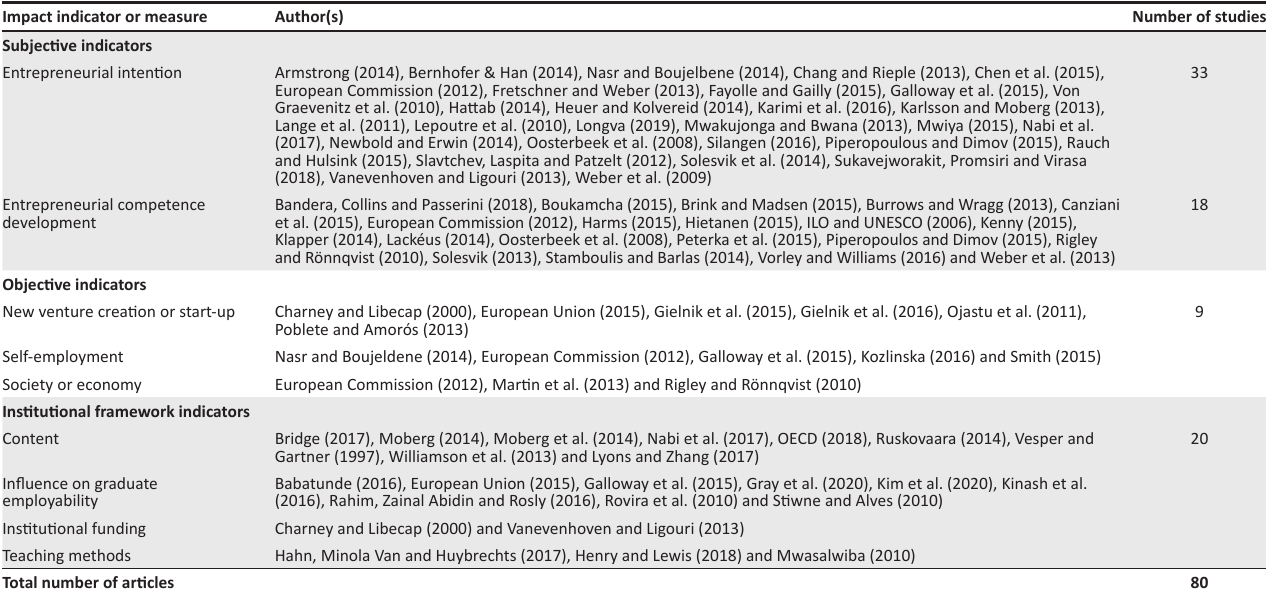
TABLE 2: Impact indicators in measuring entrepreneurship education. Impact indicator or measure